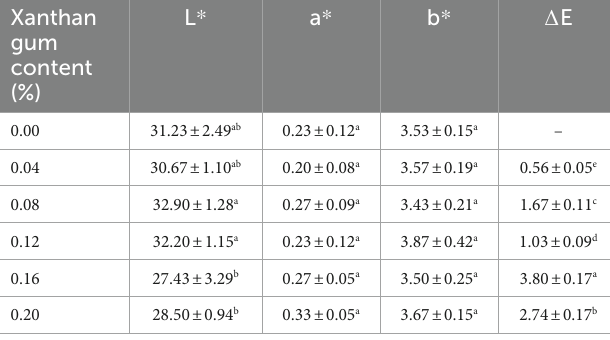
TABLE 3 Color parameters of protein powder gel with different xanthan gum contents. Xanthan gum